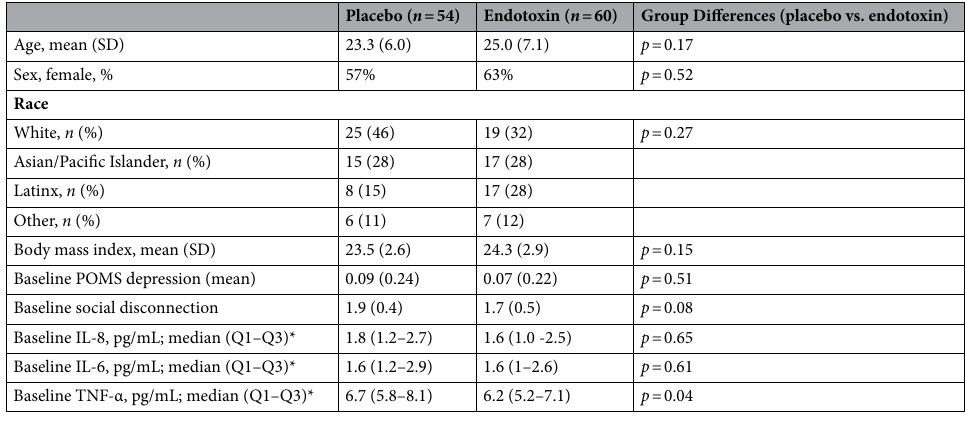
Table 1. Baseline characteristics of the sample variable. *Values were transformed by natural logarithm before all statistical analyses, but original scale medians and IQR are presented